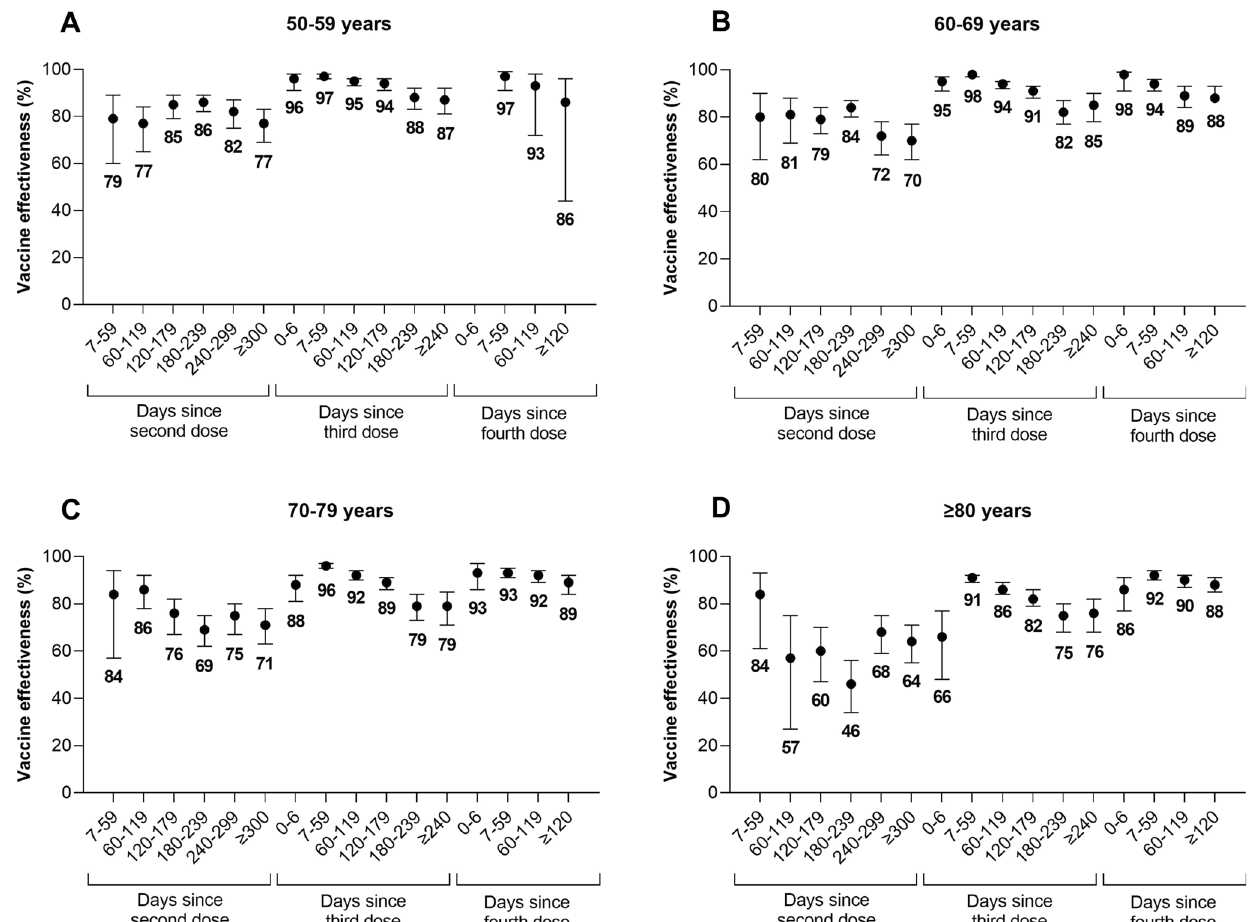
Fig. 1 | Vaccine effectiveness and 95% con fi dence intervals by time since vac- cination. Vaccine effectiveness (presented as proportions out of 100 percentage points) and 95% con fi dence intervals of 2, 3, and 4 doses of monovalent mRNA COVID-19 vaccines against Omicron-associated severe outcomes by time since vaccination among community-dwelling adults aged ( A ) 50 – 59 years, ( B ) 60 – 69